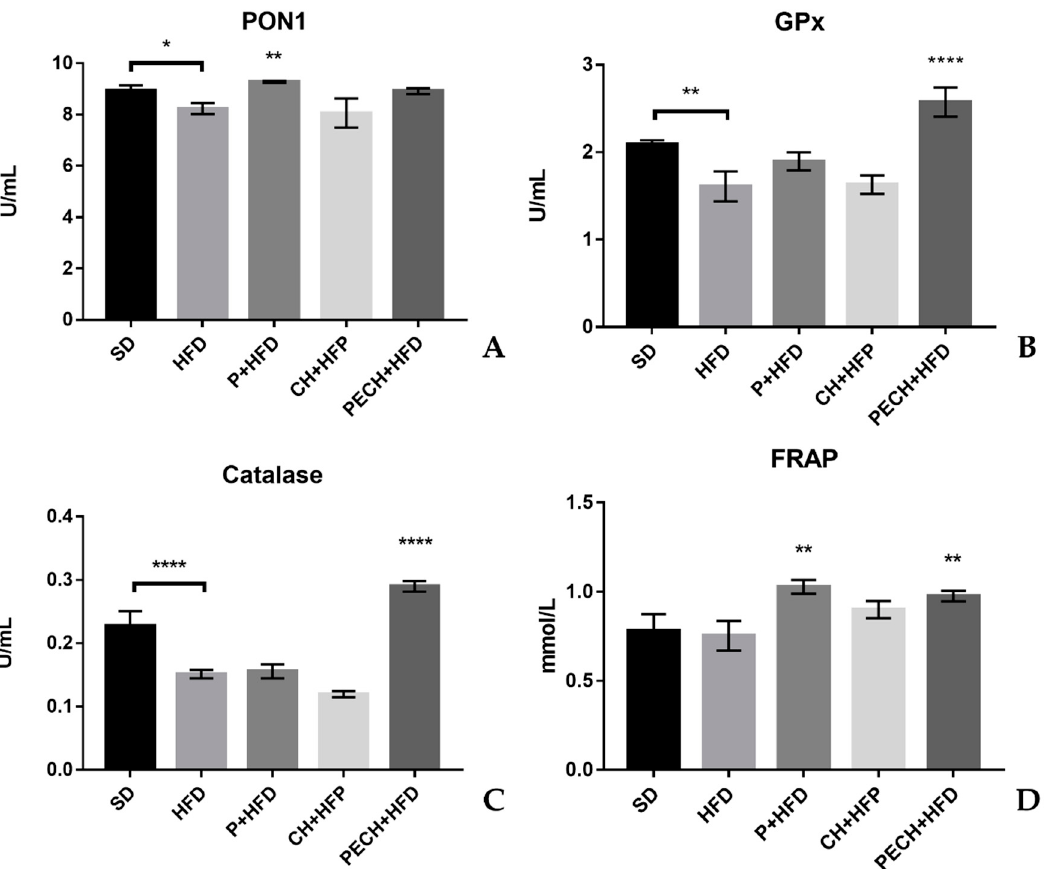
Figure 6. Effect of the different diets on antioxidant biomarkers. ( A ) PON1, ( B ) GPx, ( C ) Catalase, ( D ) FRAP. The different diets compared were standard diet, SD, n = 4), high-fat diet (HFD, n = 8), phenolic-enriched high-fat diet (P + HFD, n = 8), lyophilized cooked ham enriched high-fat diet (CH + HFD, n = 8) and lyophilized phenolic enriched cooked ham enriched high-fat diet (PECH + HFD, n = 8). HFD mean results were compared against P + HFD, CH + HFD and PECH + HFD diets, significant differences are expressed as * p < 0.05 ** p < 0.01 **** p < 0.0001. When they exist, differences between SD and HFD were represented with ” ∩ ”.